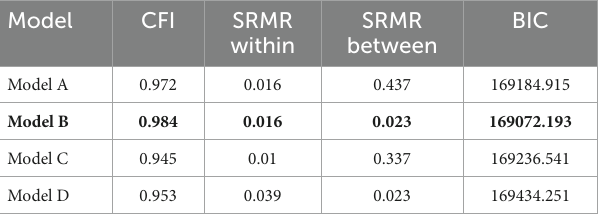
TABLE 4 Fit indices for two-level models A–D.